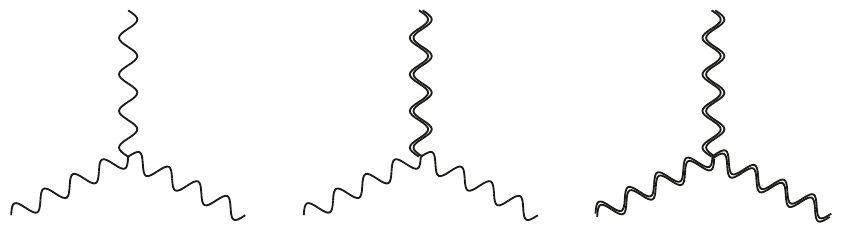
Figure 1 . Typical structures of virtual particles in the loop, the single wavy lines denote gluons or photons, while the double wavy lines denote gravitons.